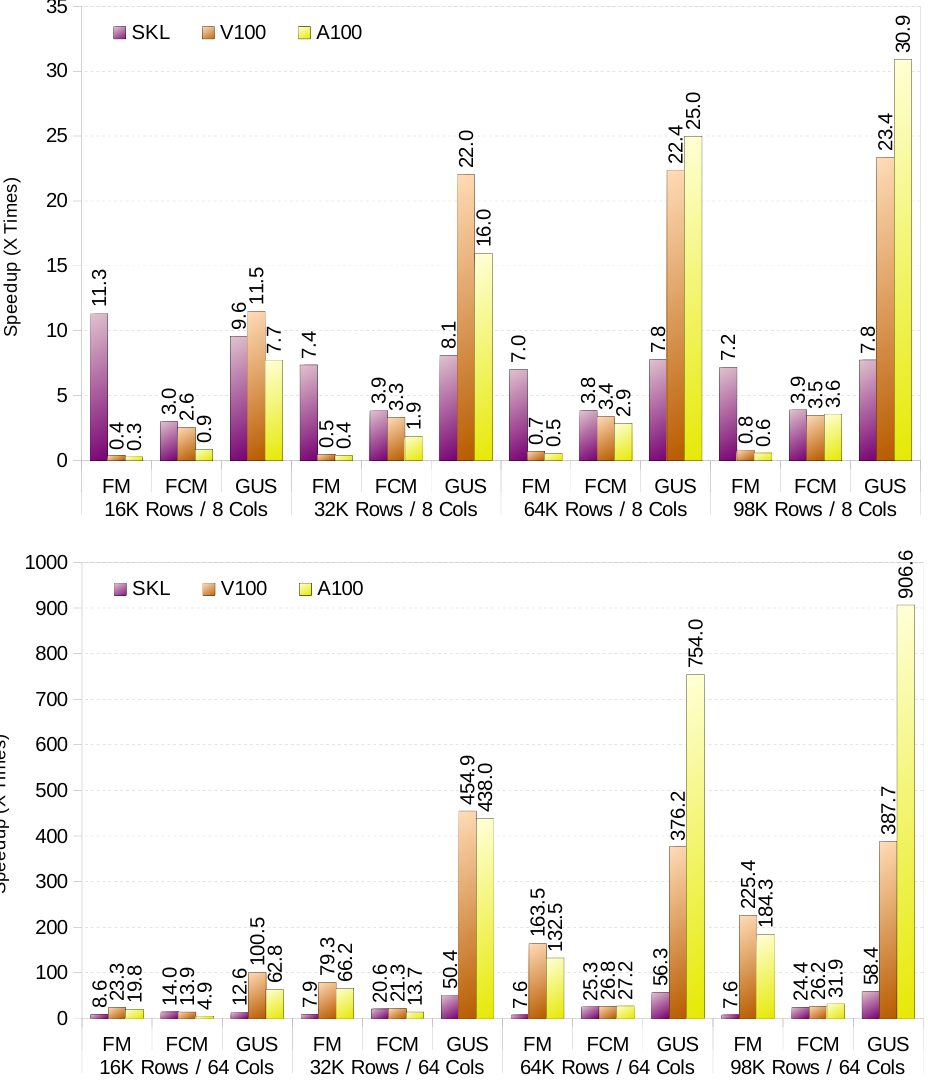
Figure 1. Speed-up (normalised to scalar code running on one